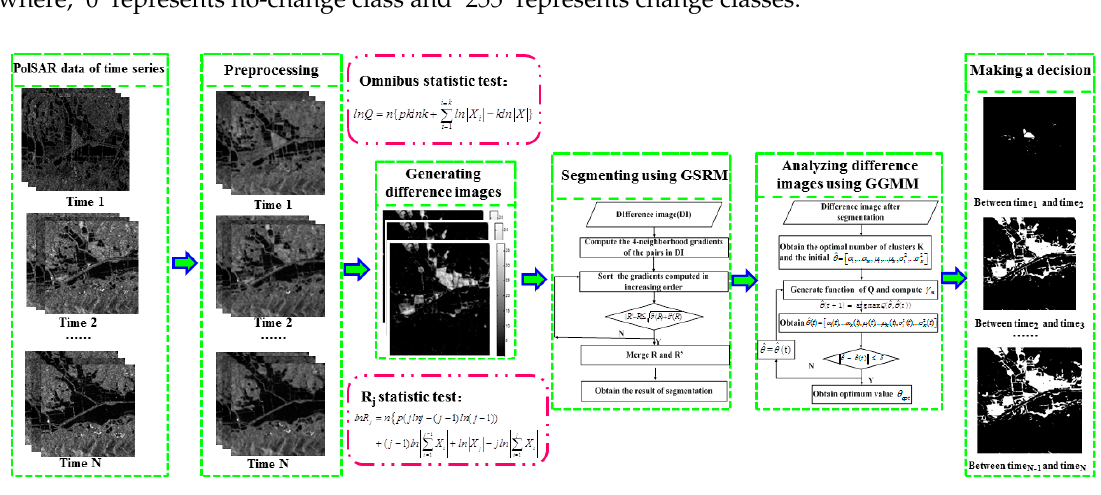
Figure 1. The procedure of the proposed method.